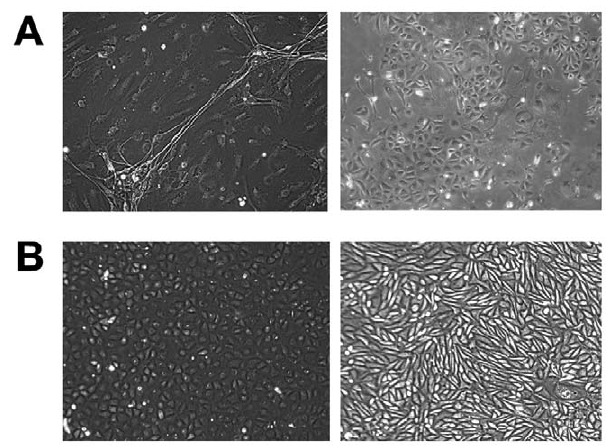
Figure 1. Morphological differences observed for primary cell cultures derived from P.alecto tissues. (A) Cells derived from a brain (left) and kidney (right) after 5 days in primary cell culture. (B) Cells derived from liver (left) and kidney (right) after 12 days in primary cell culture.